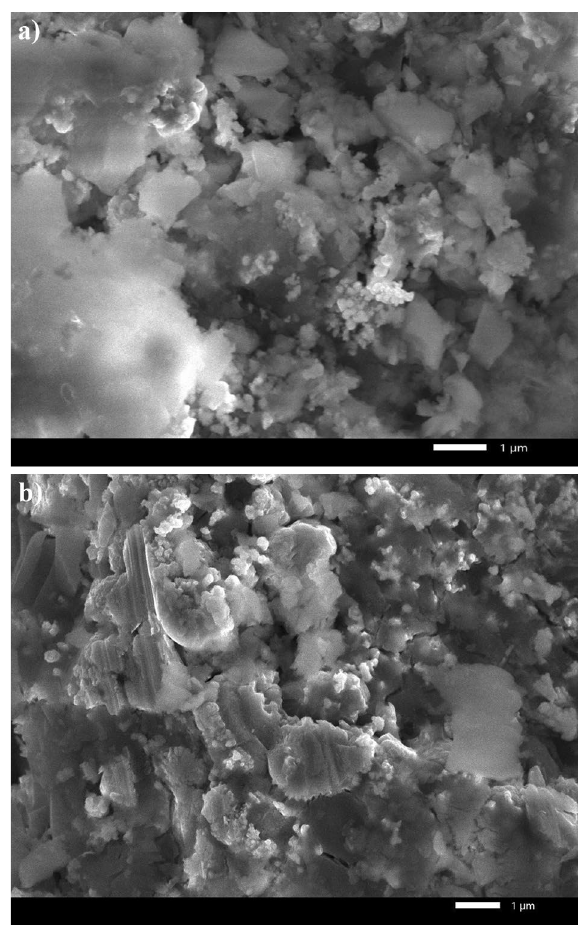
Figure 10. The SEM micrographs of SHP coated steel by ( a ) Ni@G@MA and ( b ) Ni@Cr-G@MA after abrasion test.